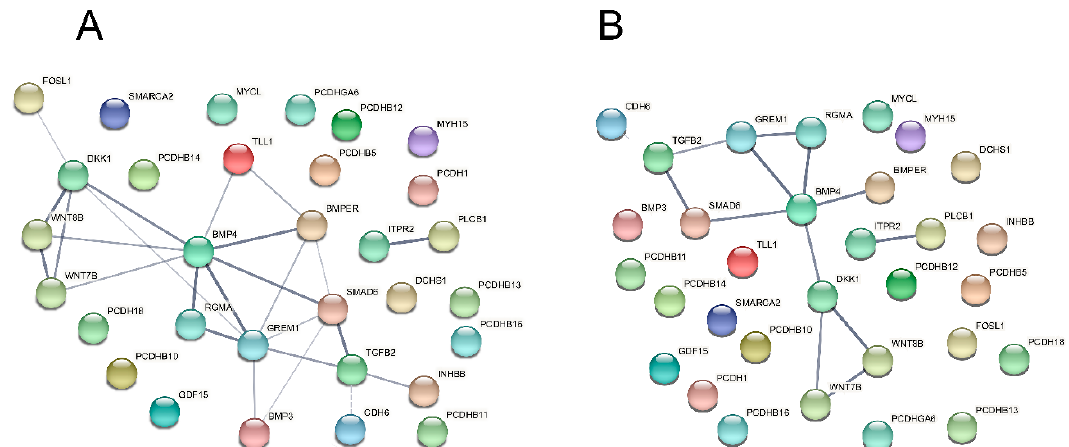
Figure 15. PPI networks consisting only of differentially expressed genes from CA β 3 cells that were overrepresented in the TGF β 2, Wnt and CAD signaling pathways demonstrate a significant number of potential interactions. Genes from Table 6 along with four additional genes ( DKK1 , BMPER , RGMA and GREM1 ) that have been shown to participate in one or more of these pathways, were entered into the STRING database. ( A ) Network calculated using a medium (0.4) statistical confidence; PPI enrichment p -value = 1 × 10 − 16 . (Interactive link for Figure 15A: permanent link: https://version-11-0b.string-db.org/cgi/network?networkId=bxHIv7XuhKtR) (accessed on 20 June 2021). ( B ) Network calculated using a high (0.7) statistical confidence; PPI enrichment p -value = 5.72 × 10 − 12 . (Interactive link for Figure 15A: permanent link: https://version-11-0b.string-db.org/cgi/network?networkId=bWKleDuHyVqt) (accessed on 20 June 2021). Both PPI enrichment scores indicate that these networks have significantly more interactions than expected for a random collection of input genes at the same confidence level. The proteins for which there were no connections to be mapped are also displayed.